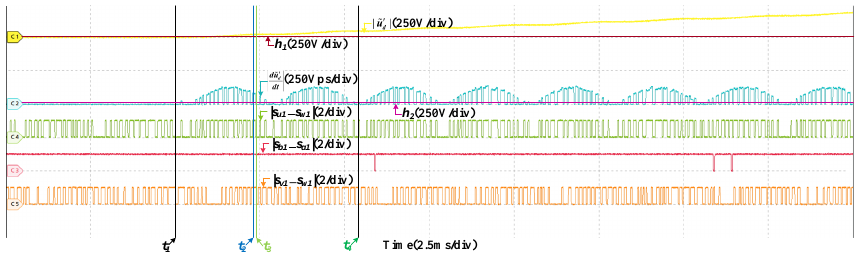
Figure 17. HIL results when the scaling fault occurs in S Cu at 300